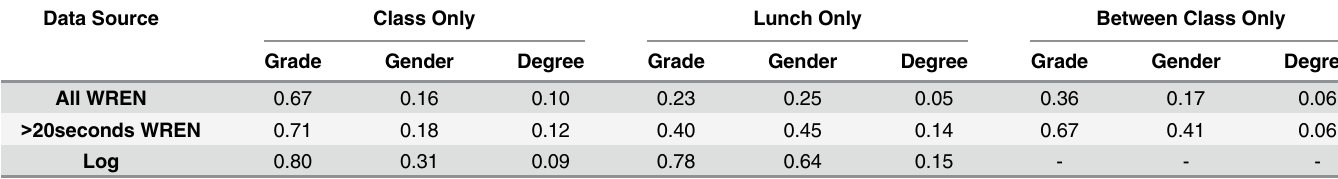
WREN data were used including all contacts and also only those greater than 20 seconds. Between class contacts were only recorded by